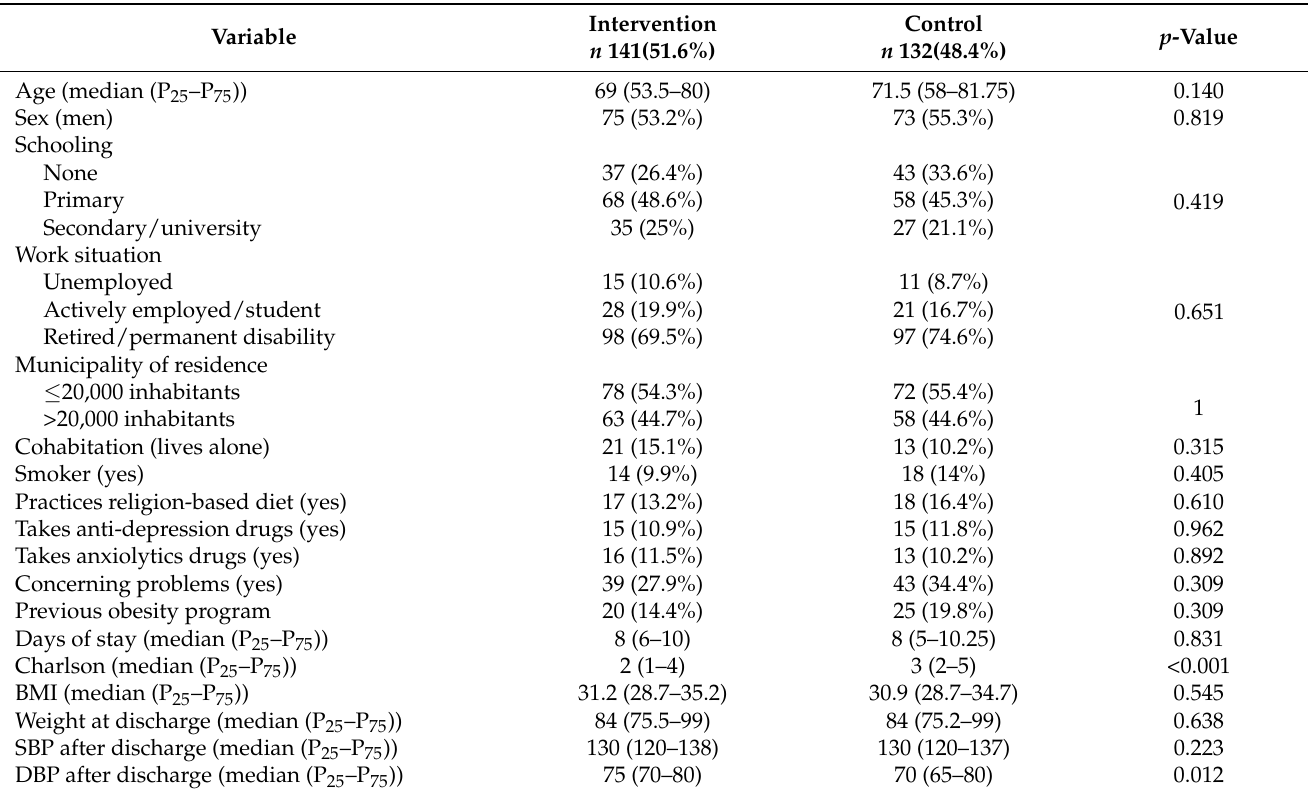
Table 1. Comparison of characteristics between intervention and control